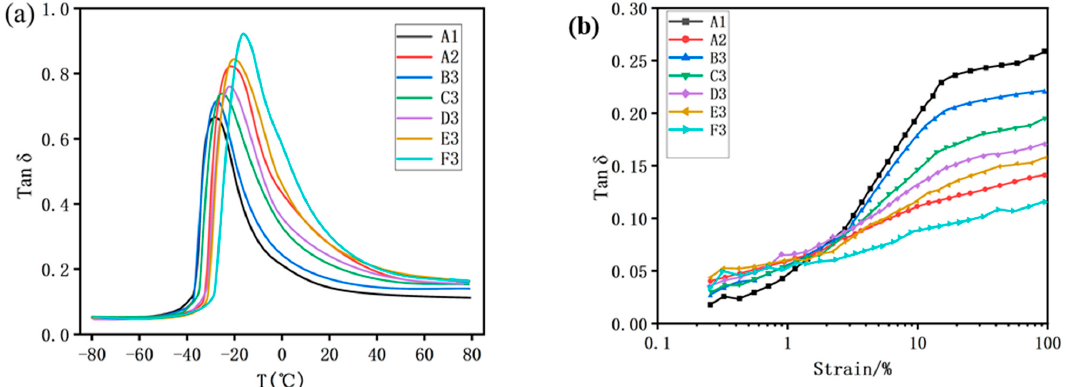
Figure 7. Dynamic properties of PS-SSBR / BR, ESSBR-SSBR / BR and TS-SSBR / BR composites: ( a ) the relation of the tan δ with temperature and ( b ) the relation of the tan δ with strain amplitude. Table 3. tan δ at 0 ◦ C, 60 ◦ C and T g (glass transition temperature) of PS-SSBR / BR, ESSBR-SSBR / BR and TS-SSBR / BR composites.